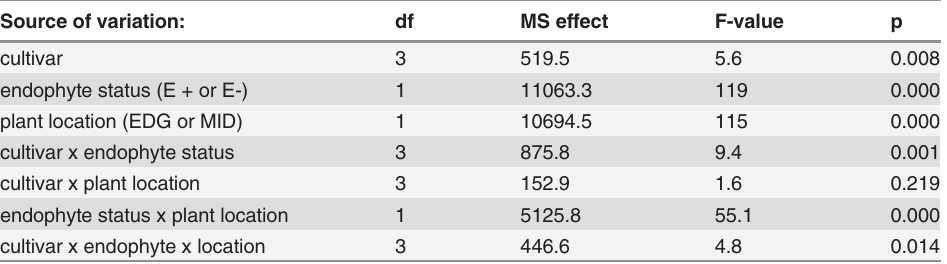
Table 3. Results of ANOVA showing effects of cultivars, plant endophyte status, plant location and their interactions on mean endophyte infection of perennial ryegrass cultivars. Source of